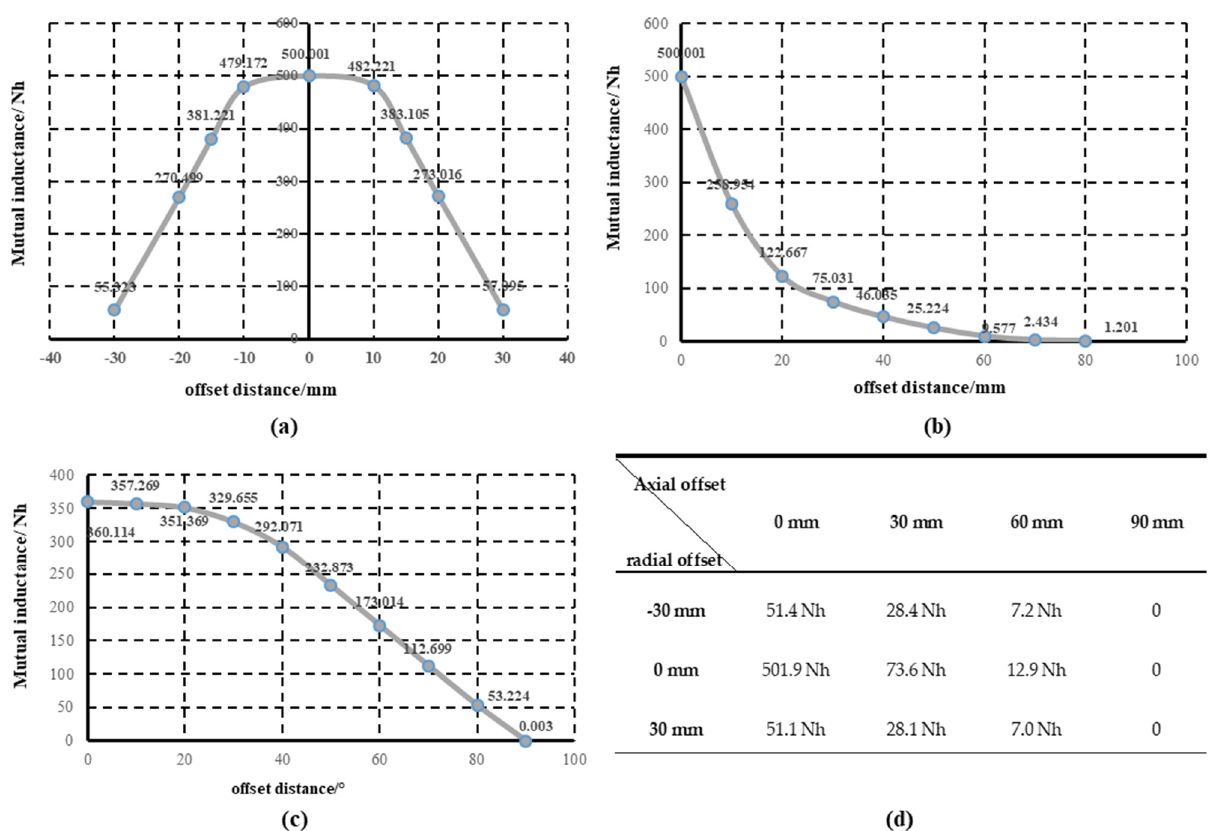
Figure 4. Mutual inductance changes when the coil offsets: ( a ) effect of radial offset on mutual inductance; ( b ) influence of axial offset on mutual inductance; ( c ) influence of angle offset on mutual inductance; ( d ) simultasneous radial and axial offset changes in mutual inductance.